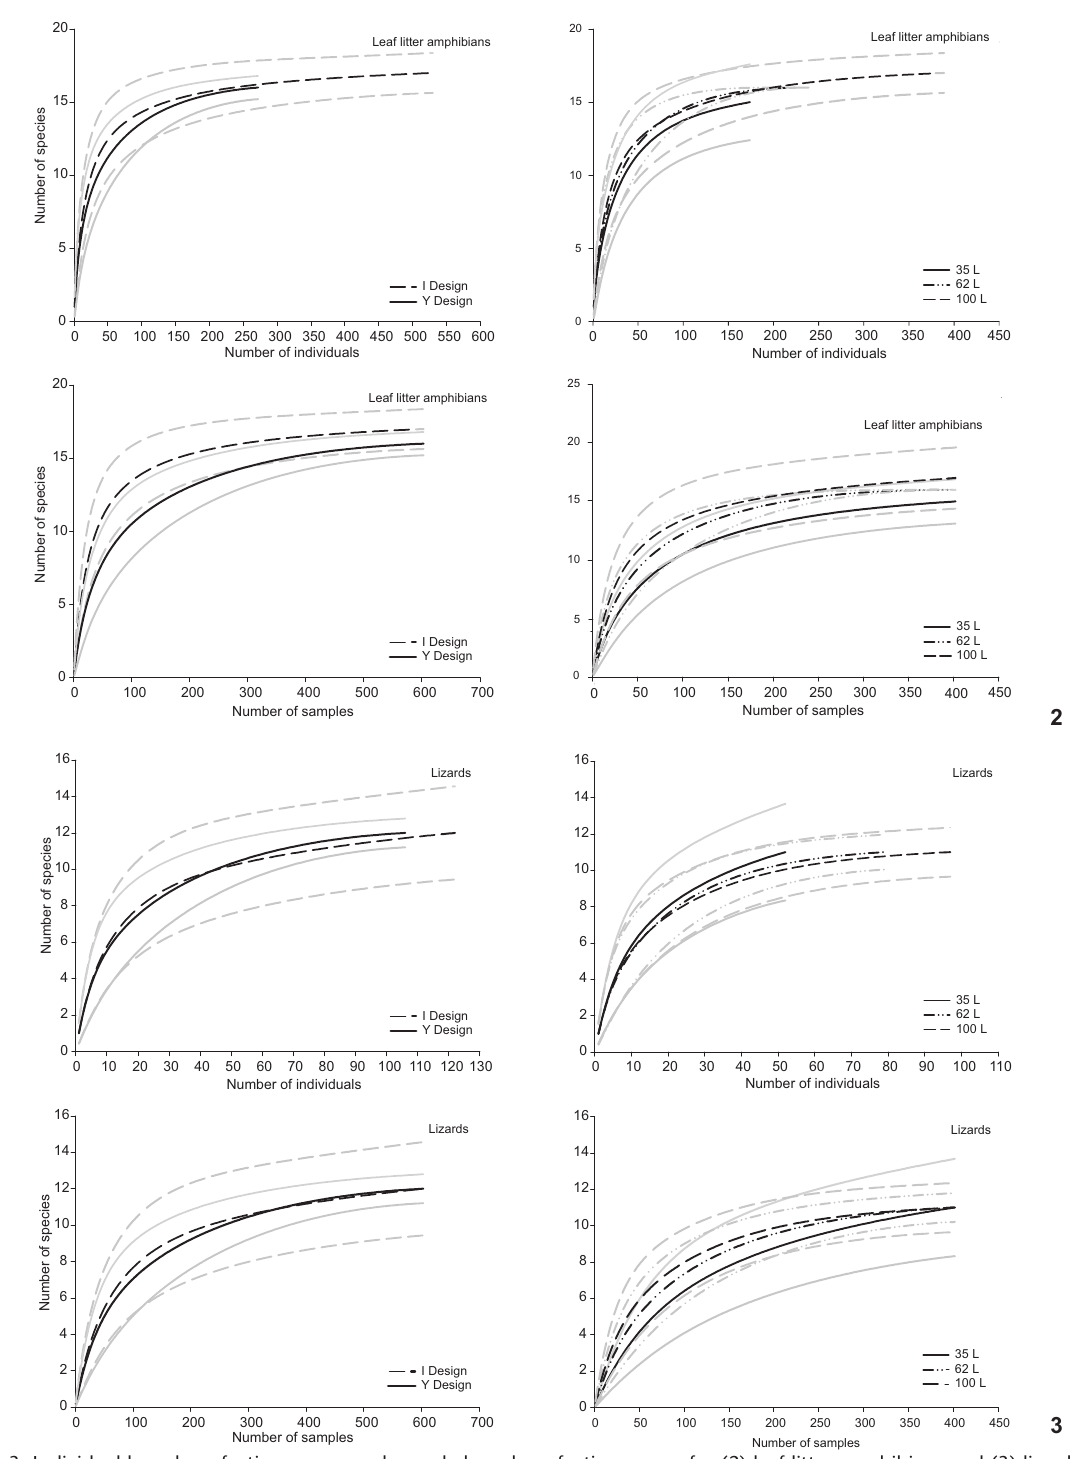
Figures 2-3. Individual based rarefaction curves and sample based rarefaction curves for (2) leaf litter amphibians and (3) lizards cap- tured by I and Y pitfall trap designs, and 35, 62 and 100 L pitfall traps sizes. Gray lines represent 95% confidence